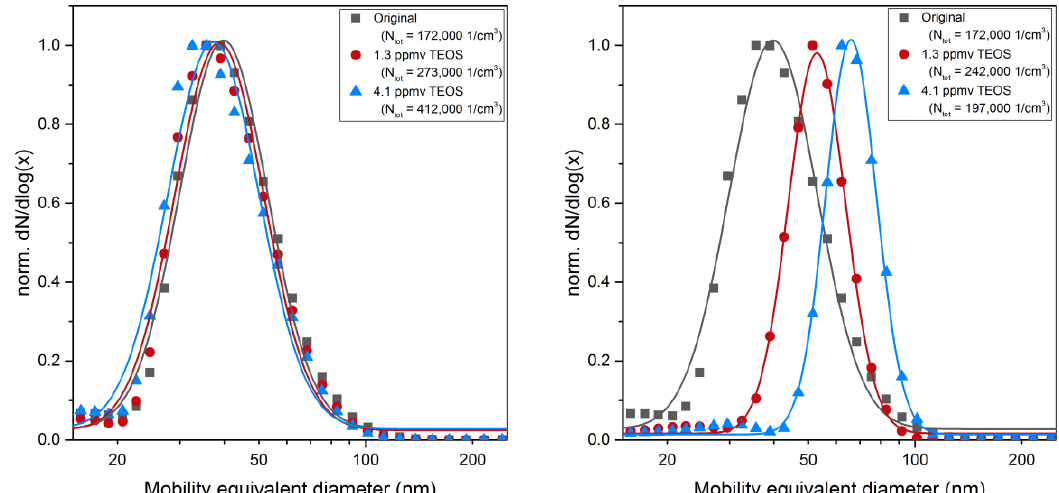
Figure 10. Change in mobility equivalent diameter depending on the precursor concentration without ( left ) and with ( right ) plasma for agglomerates t Reaction = 83 s).